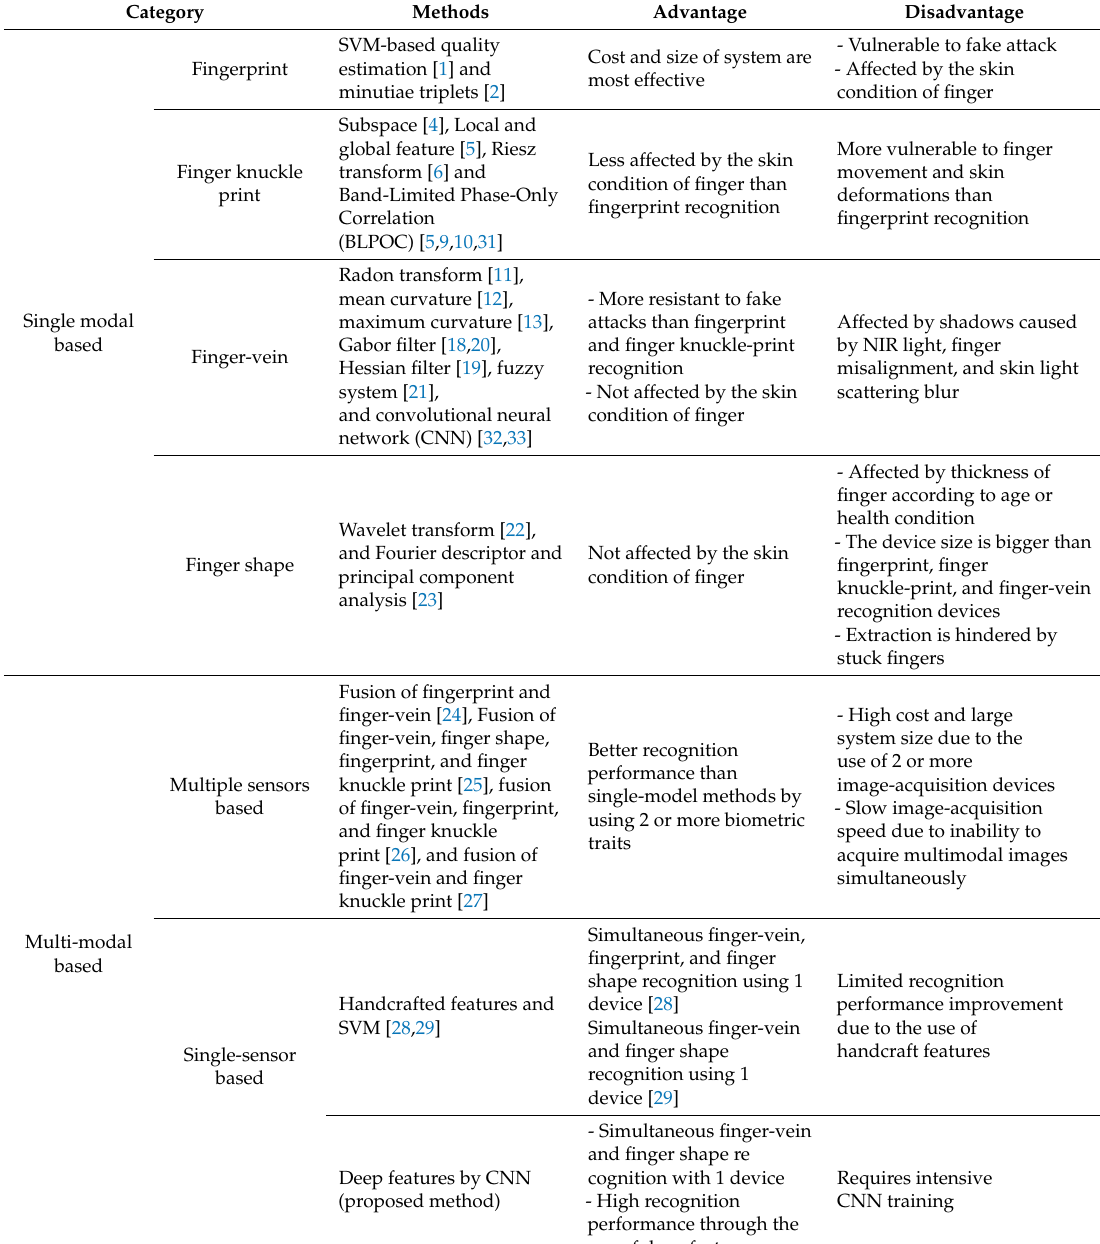
Table 1. Comparisons of proposed and previous research on finger-based